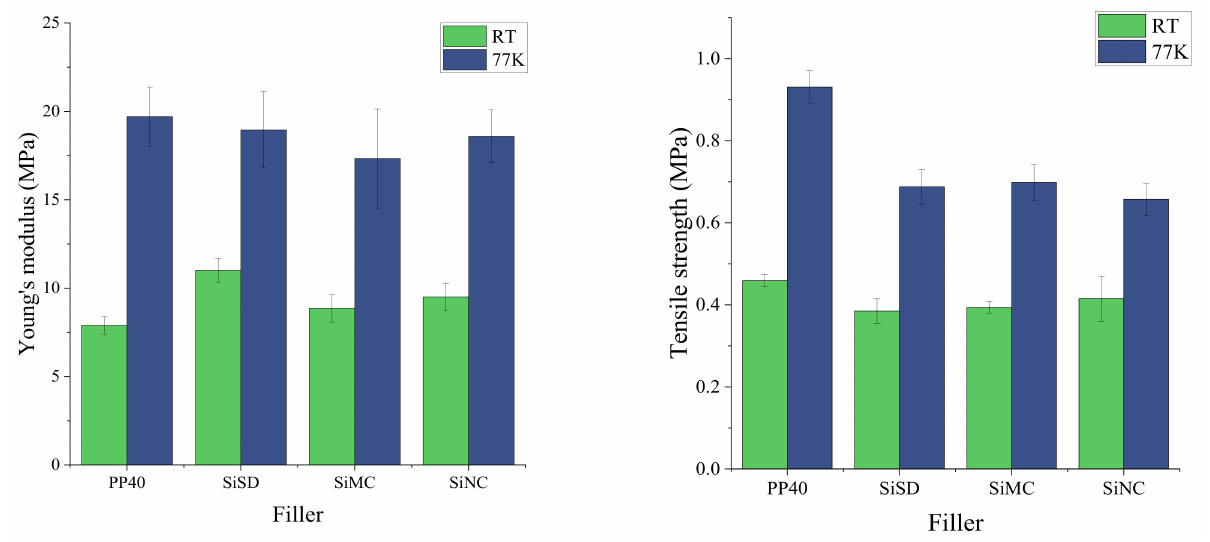
Figure 12. Young’s modulus ( left ) and tensile strength ( right ) of neat PP40 and PP40 composites with 1.5% filler concentration.